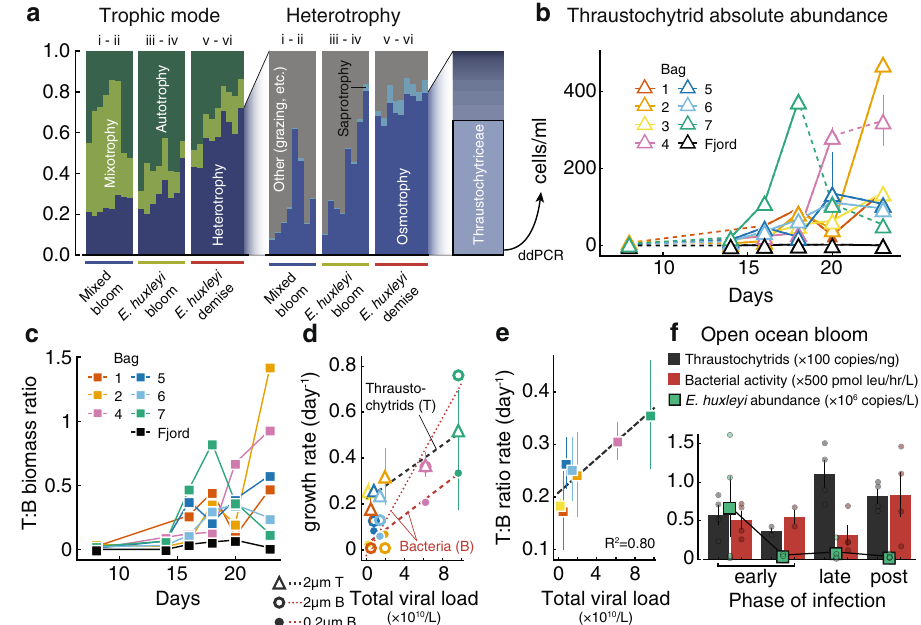
Fig.3|Viralinducedbloomdemisechangesthecompositionoforganicmatter recyclers. a Analysis of predicted eukaryotic traits plotted per phase of the E. huxleyi bloom. Relative abundance of autotrophy, mixotrophy, and heterotrophy, de fi ned through literature search (left). Trophic modes within heterotrophy, as de fi ned by 72 (right). b Absolute abundance of thraustochytrids throughout the mesocosm experiment on the 2 – 20 μ m size fraction, measured by ddPCR. Points and error bars show the mean and standard deviation across n =3 replicates. c Thraustochytrid to bacteria biomass ratios throughout the experiment duration (see Methods and Supplementary Data 1 – 4 for detailed calculation). d Correlation between total viral load and growth rate during demise phase of thraustochytrids (2 – 20 μ m) and bacteria (for the free-living fraction measured by fl ow-cytometry and for 2 – 20 μ m fraction measured by qPCR). Symbols indicate the mean, error